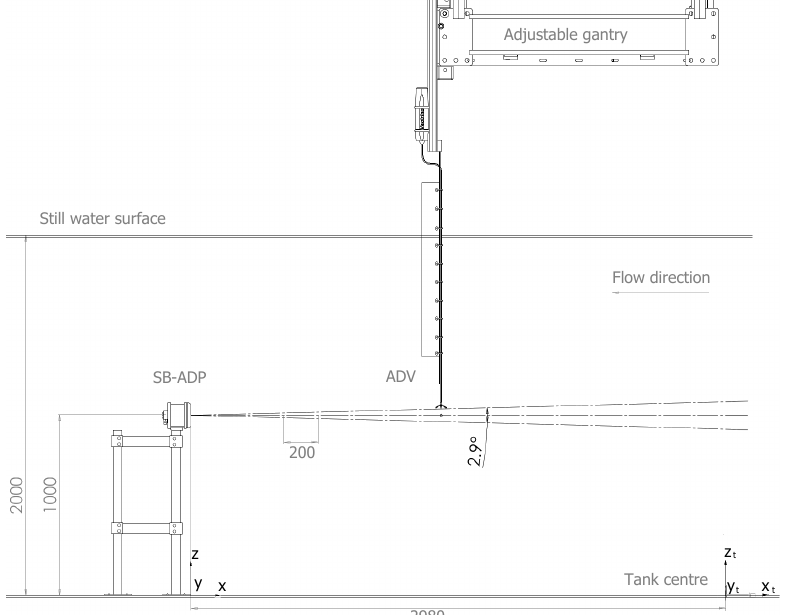
Figure 2. Diagram of the test set-up showing the Single Beam Acoustic Doppler (SB-ADP) pointed into the flow, and its theoretical acoustic beam binned into measurement cells. The Acoustic Doppler Velocimeters (ADV) is mounted on a x-adjustable gantry enabling point measurements within successive SB-ADP